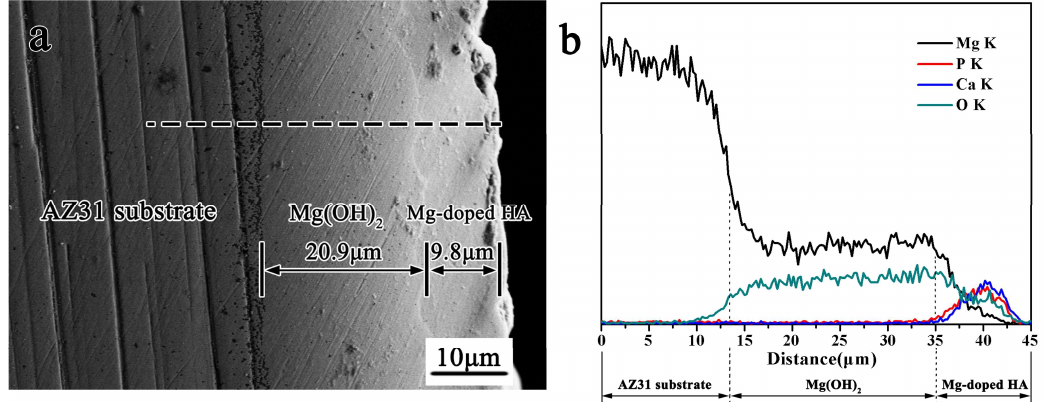
Figure 3. ( a ) The cross-sectional microstructure of CN1. ( b ) The elements’ distribution along the dotted line in Figure 3a.